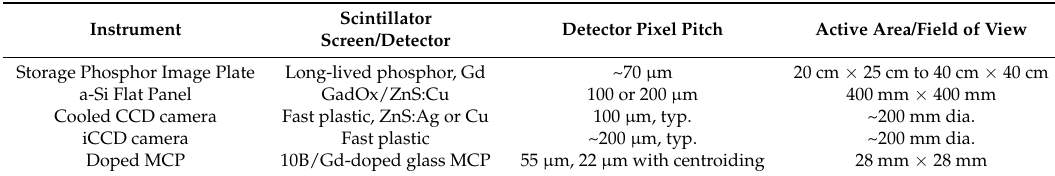
Table 2. Neutron-imaging detectors used at LANSCE.